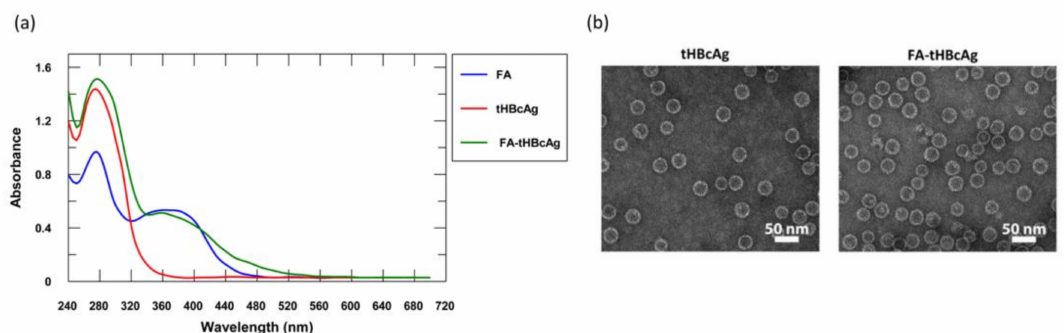
Figure 1. Conjugation of truncated HBcAg mutant (tHBcAg) virus-like nanoparticles (VLNPs) with folic acid. ( a ) Spectra of folic acid (FA), tHBcAg VLNPs (tHBcAg), and FA-conjugated tHBcAg VLNPs (FA-tHBcAg); ( b ) Transmission electron micrographs of tHBcAg VLNPs. tHBcAg VLNPs (tHBcAg) and FA-conjugated tHBcAg VLNPs (FA-tHBcAg) were examined using transmission electron microscopy (TEM). The white bars indicate 50 nm.